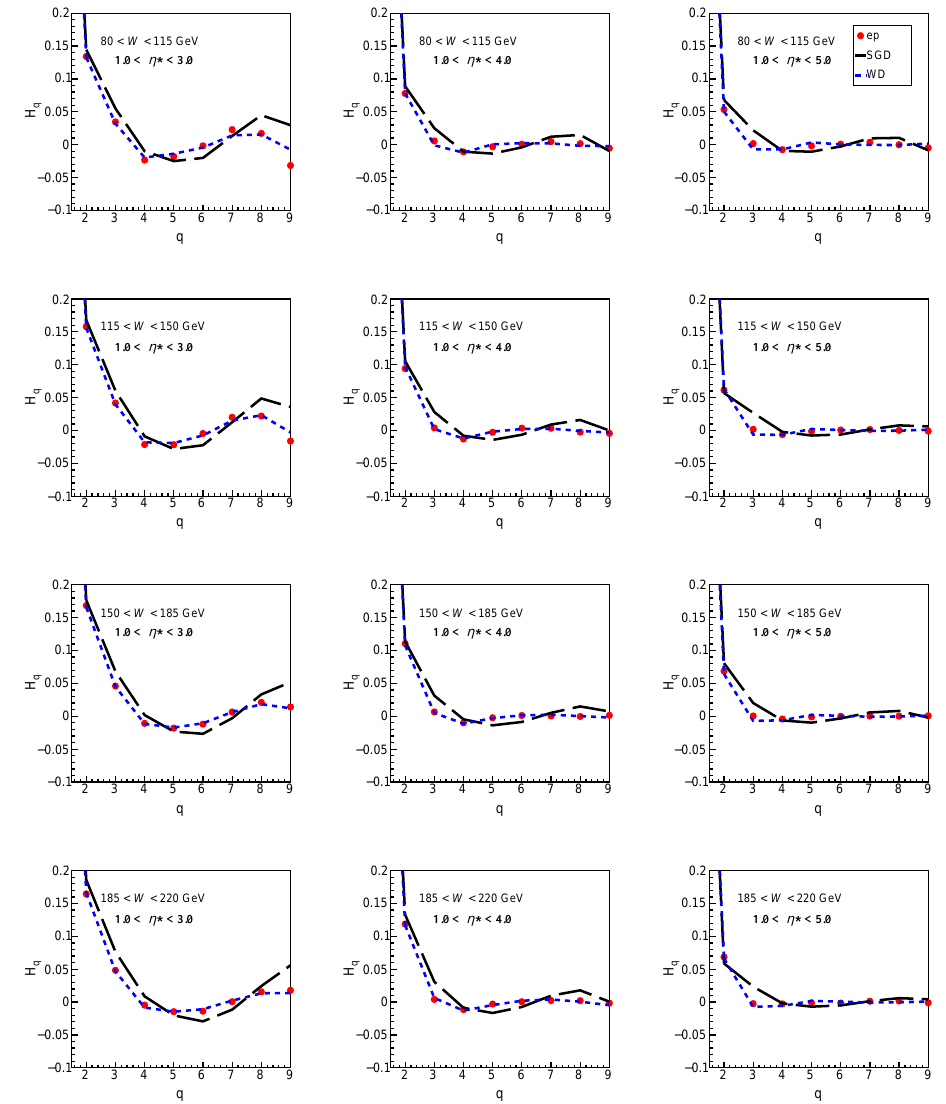
Figure 14. H q moments from the SGD and WD fits in comparison to the data [33] for different W ranges and different η ∗